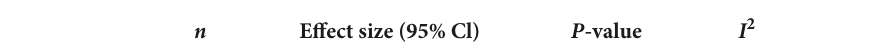
TABLE 2 The results of subgroup